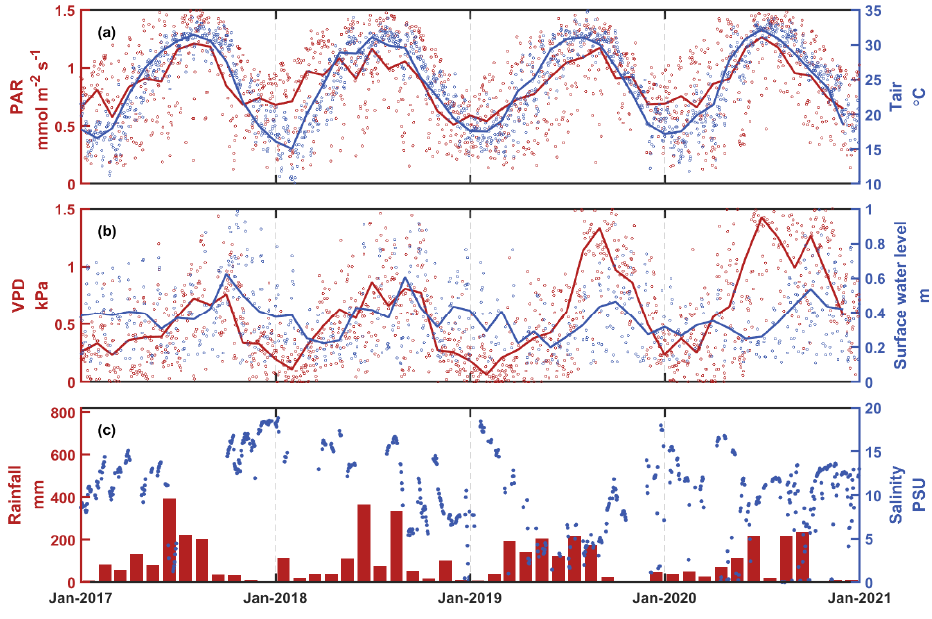
Figure 2. Seasonal and annual variations in daytime mean values of environmental variables (( a ): photosynthetically active radiation and air temperature, ( b ): vapor pressure deficit and maximum surface water level, ( c ): rainfall and surface water salinity) from January 2017 to December 2020. Lines and bars indicate monthly mean values. PAR = photosynthetically active radiation; Tair = air temperature; VPD = vapor pressure deficit. Table 1. Seasonal mean values of environmental, spectral, and carbon-related variables from January 2017 to December 2020, with higher VPD and lower rainfall values indicating the 2019–2020 drought stress highlighted in bold.